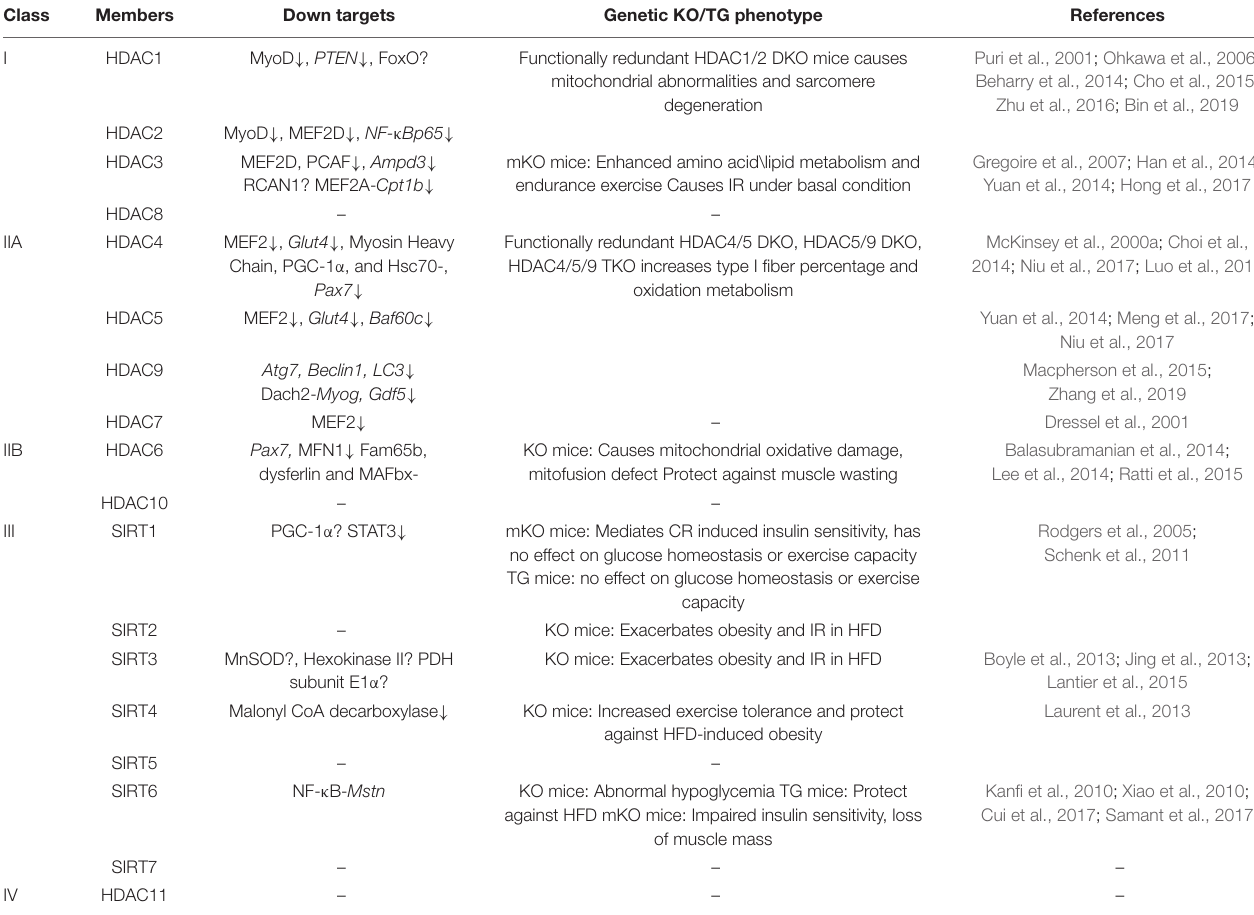
TABLE 1 | The targets of HADCs in skeletal muscles and their physiological